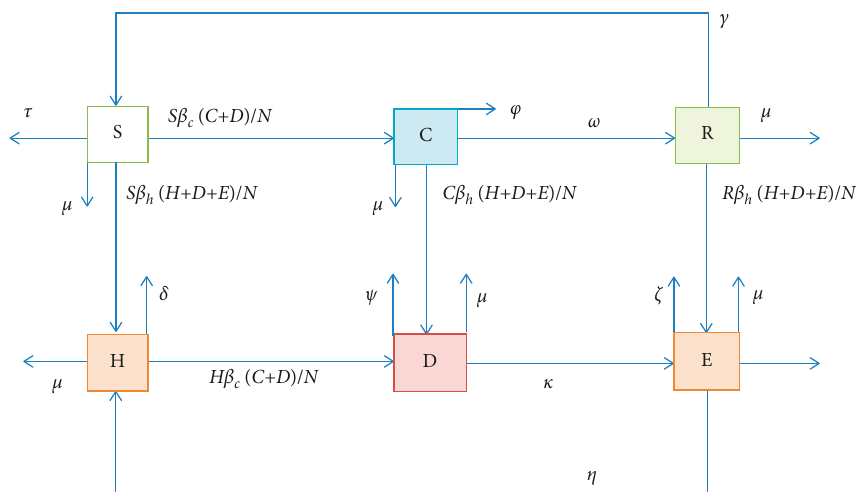
Figure 1: Flow diagram of HIV and cholera